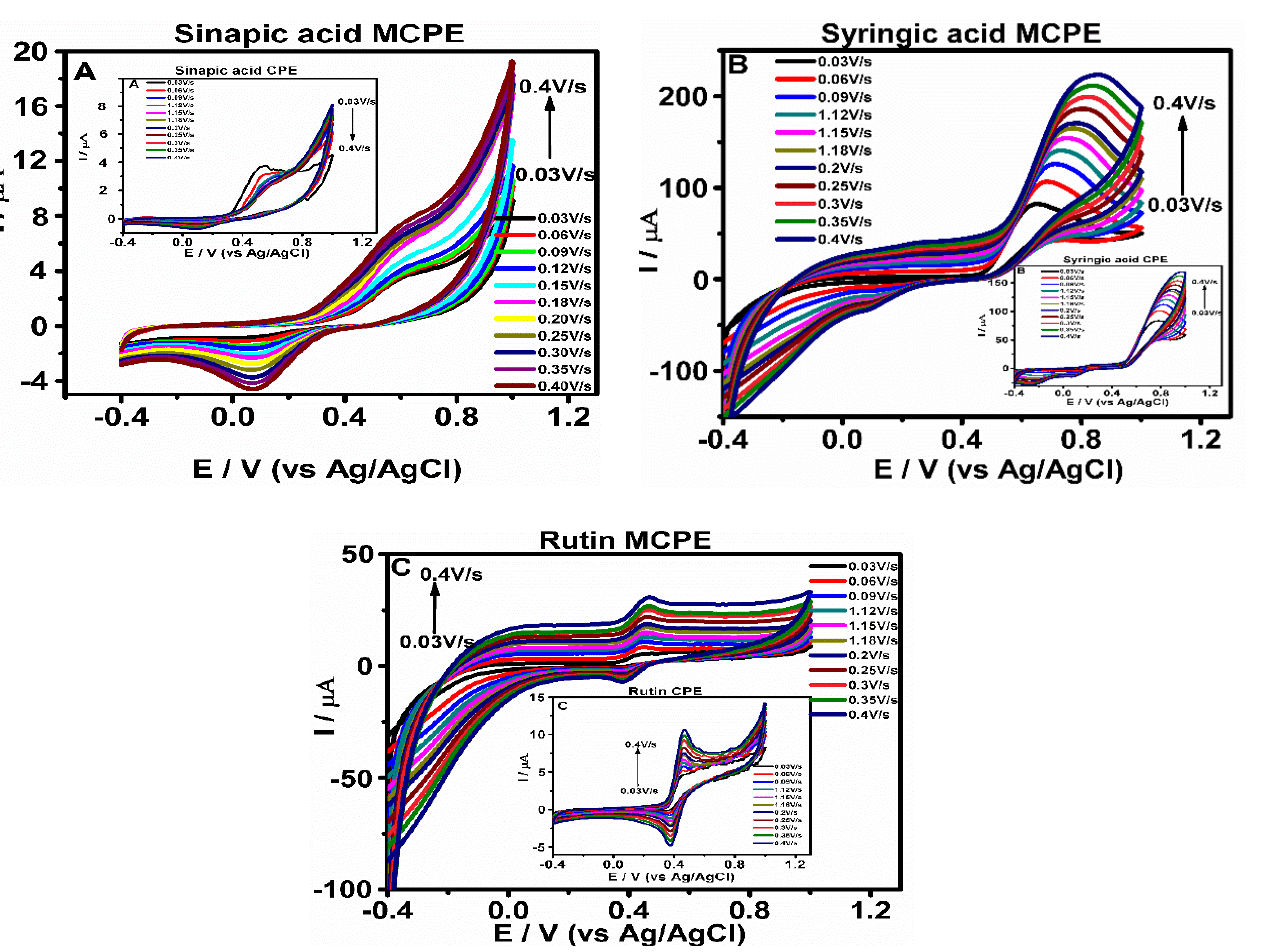
Figure 6. Cyclic voltammograms ( A – C ) show the electrochemical oxidation and reduction behavior of phenolic compounds at CPE and MCPE in 0.5 M of ABS having pH 4.8 and scan rates of 0.03, 0.06, 0.09, 0.12, 0.15, 0.18, 0.20, 0.25, 0.3, 0.35 and 0.40 V/s, respectively, with a reversible scanning potential range of − 0.4 to 1.0 V. Table 2. Linear regression equations show the dependence of redox peak current Ip on the square root of scan rate ν 1/2 (V/s) 1/2 for controlled diffusion and dependence of redox peak current Ip on scan rate ν (V/s) for controlled adsorption for phenolic compounds at bare CPE and MCPE with their slopes and R-square values. Table 3. Linear regression equation showing the logarithm of anodic peak current and logarithm of scan rate (log Ip versus log ν (V/s) for the phenolic compounds at CPE and MCPE with their slopes and R-square